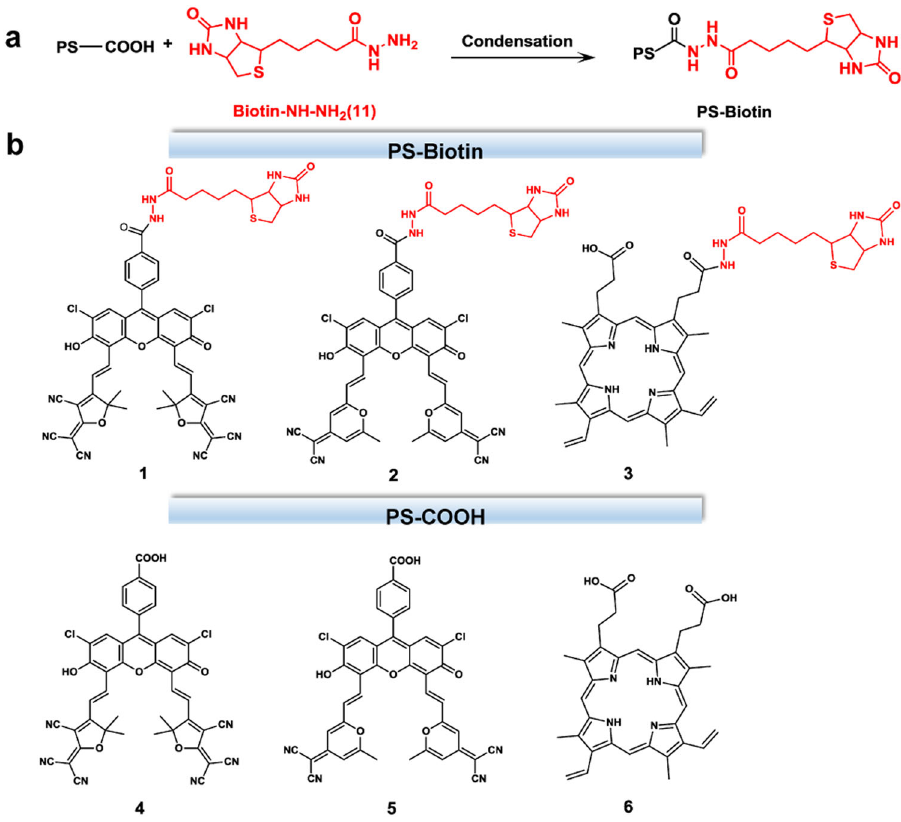
Fig. 1 The synthesis route for biotinylation of photosensitizers from PS-COOH to PS-Biotin. a The carboxyl-terminal photosensitizer PS-COOH is condensed with hydrazine modi fi ed biotin to form PS-Biotin. b Chemical structures of compounds (PS-Biotin and PS-COOH) 1 –